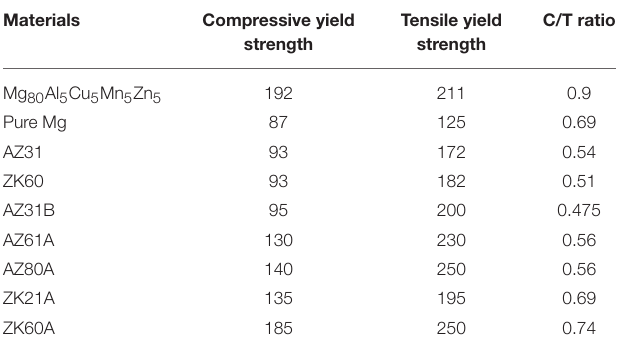
TABLE 2 | List of wrought Mg and alloys with their respective compression to tension asymmetry (C/T)